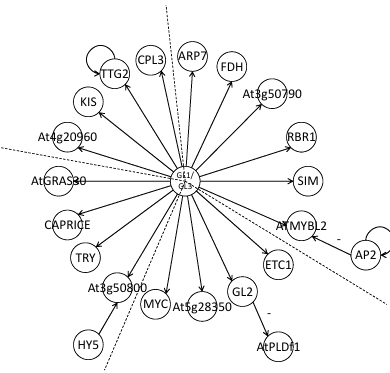
Figure 9: A network in Arabidopsis